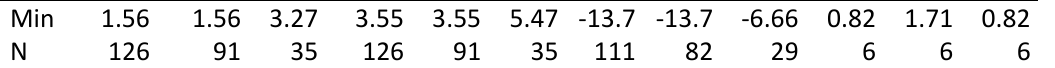
Table 5: Efficiency Ratios of Entire Sample (in percent) AU CD Total SAC MPC Total SAC MPC Avg. Md.